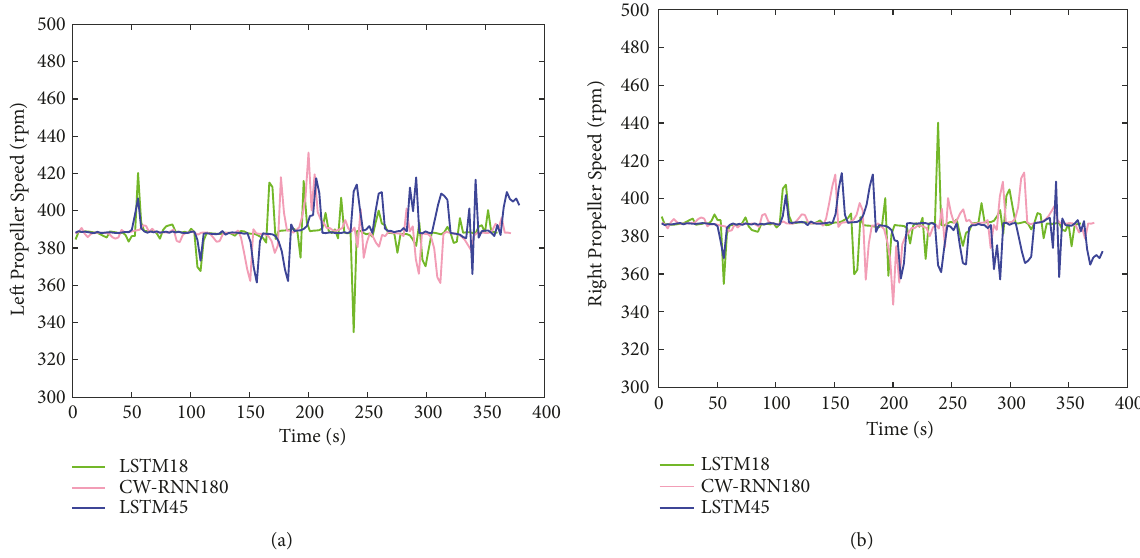
Figure 15: Curves of propeller speed controlling feedback corresponding with the different obstacle avoidance algorithms.